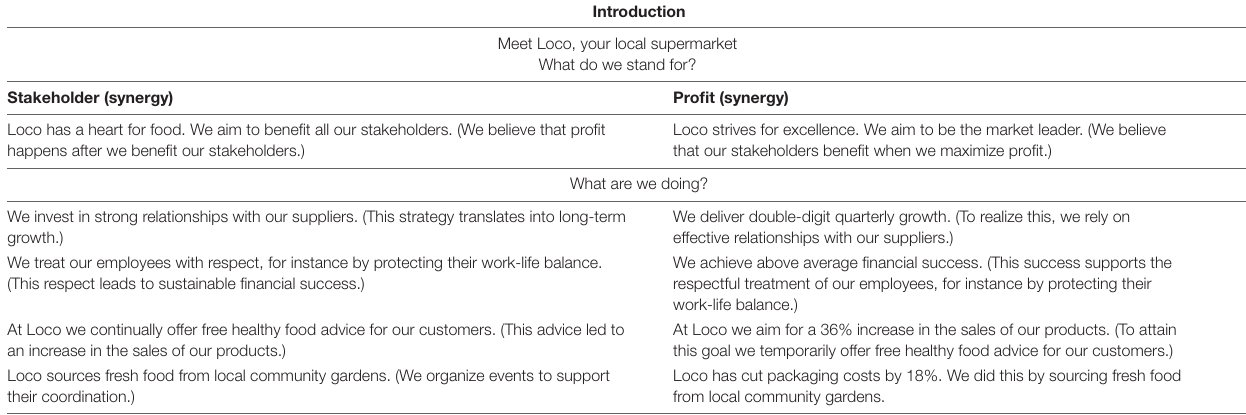
TABLE 4 | Vignette texts for experiment 5 for the stakeholder-oriented, profit-oriented, synergy, and no-synergy